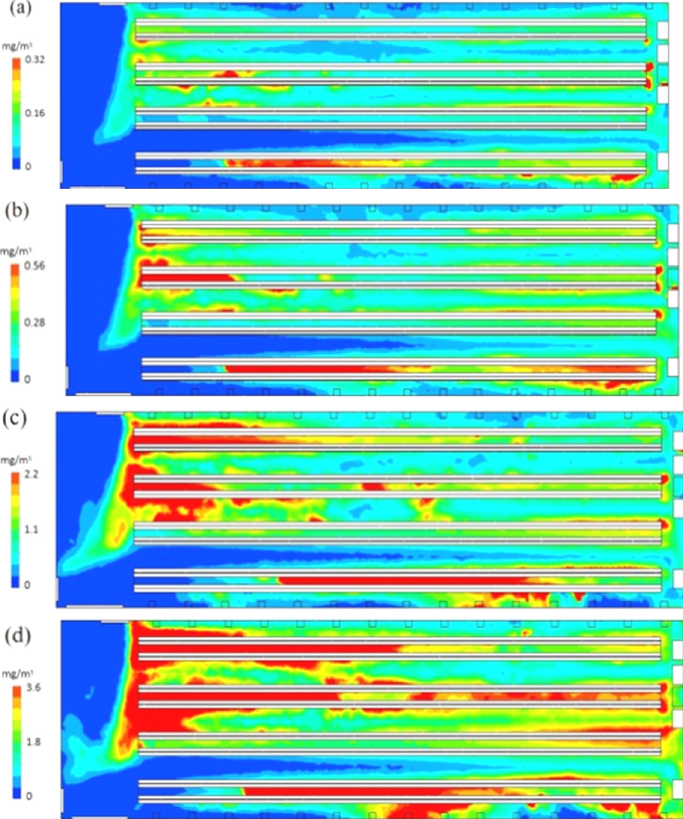
Figure 5. PM concentration distribution contours at Z = 1.5 m heights by CFD technology: ( a ) PM 1 ; ( b ) PM 2.5 ; ( c ) PM 10 ; and ( d ) TSP (inside).